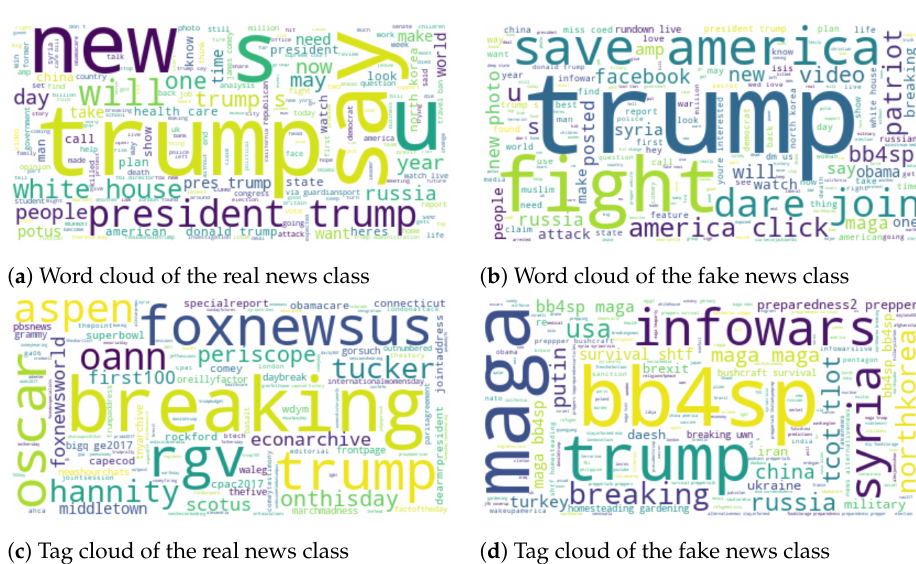
Figure 2. Topic distribution in the training